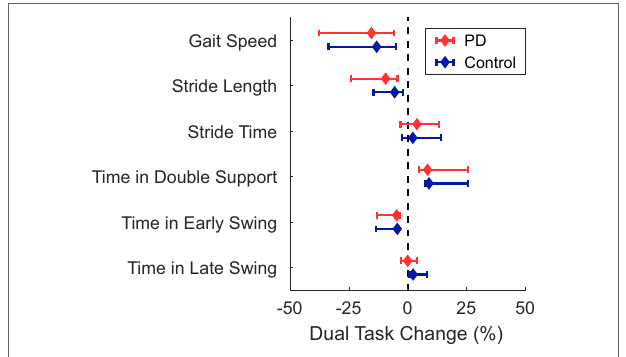
IQRs for spatiotemporal measures of gait for people with Parkinson’s disease (PD) (red) and healthy control subjects (blue). DTCs were calculated as a percentage change with respect to single-task gait. *Time spent in late swing was significantly different between groups whether calculated as a linear change (see Table 4 ), or as a percentage change. Group differences in DTCs as percentages were not tested on other spatiotemporal outcomes as the group*task interactions were not significant in the initial linear mixed